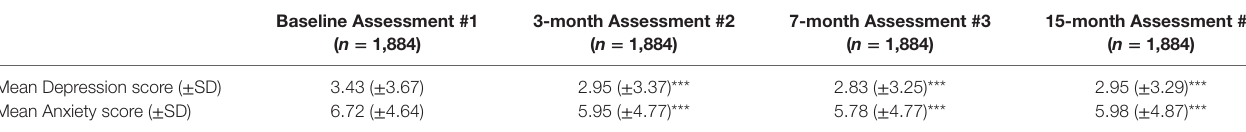
TaBle 6 | changes in Depression and anxiety scores for study population of 1,884 who completed all 4